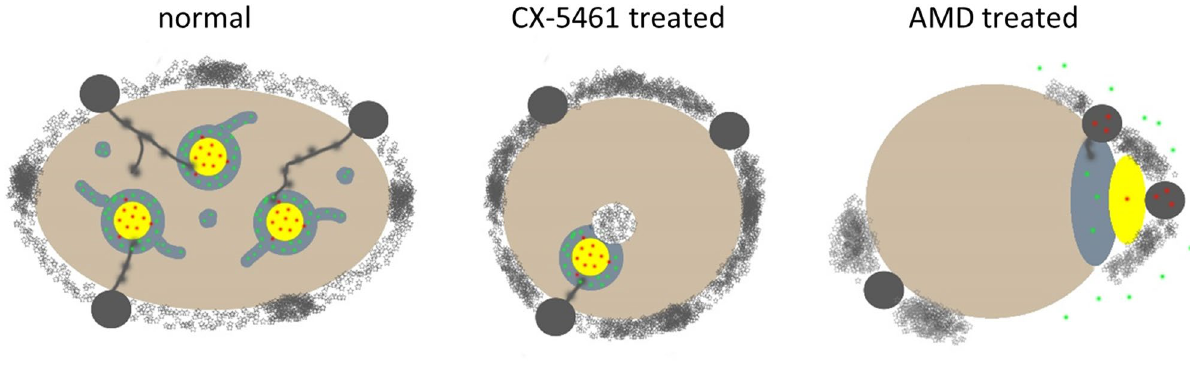
Figure 6. Schematic comparison of morphological changes induced by CX-5461 and AMD treatment. Left: untreated nucleolus (Hela cell): pol I (red dots) containing FCs (yellow) are surrounded by fibrillarin (green dots) containing DFC (grey), which extends into GC (brown); at the nucleolar periphery perinucleolar chromatin consists of stretches of decondensed and condensed chromatin including transcriptionally silent rDNA (NORs; black dots) from which strands of transcriptionally active rDNA emanate into nucleoli. Middle: CX-5461 treatment causes loss of DFC extensions and relocation of fibrillar components to the periphery while maintaining the architecture of FCs and DFCs. Intranucleolar chromatin appears frequently at the interface between FCs and DFCs and the perinucleolar chromatin extends forming a bright DAPI-positive ring around nucleoli, containing mainly condensed chromatin partly including NORs and some stretches of decondensed chromatin. Right: treatment with high doses of AMD resolves FC/DFC architecture causing spatial segregation of the three nucleolar components; rDNA retracts into NORs as does most of pol I while the majority of fibrillarin redistributes into the nucleoplasm; NORs and perinucleolar chromatin appear in patches forming nucleolar caps (scheme compiled with data from 10,59,60